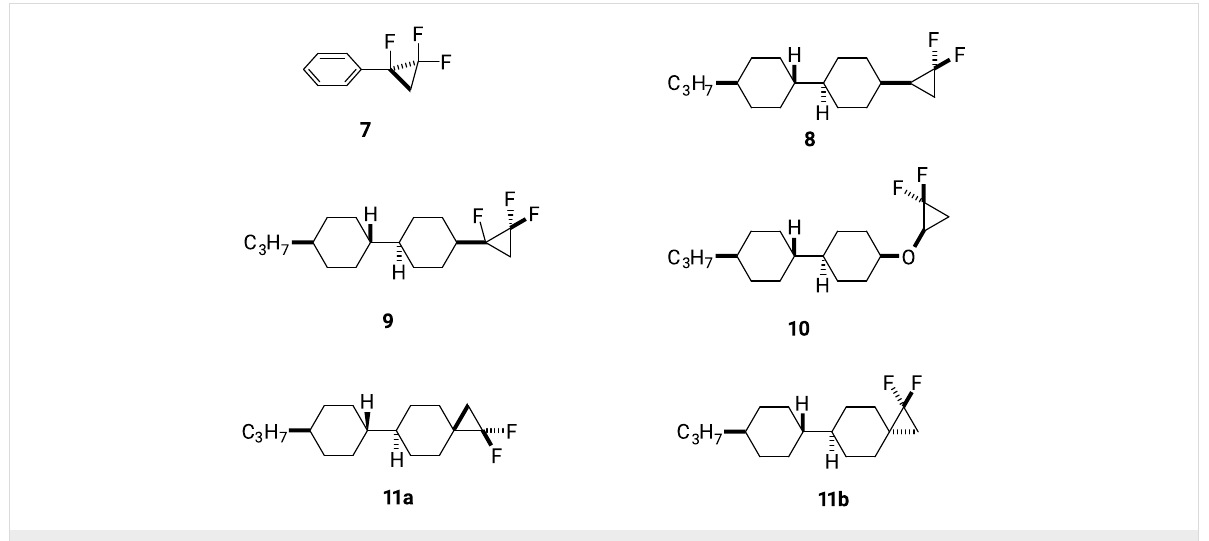
Figure 2: Synthetic candidate LC targets 8–11